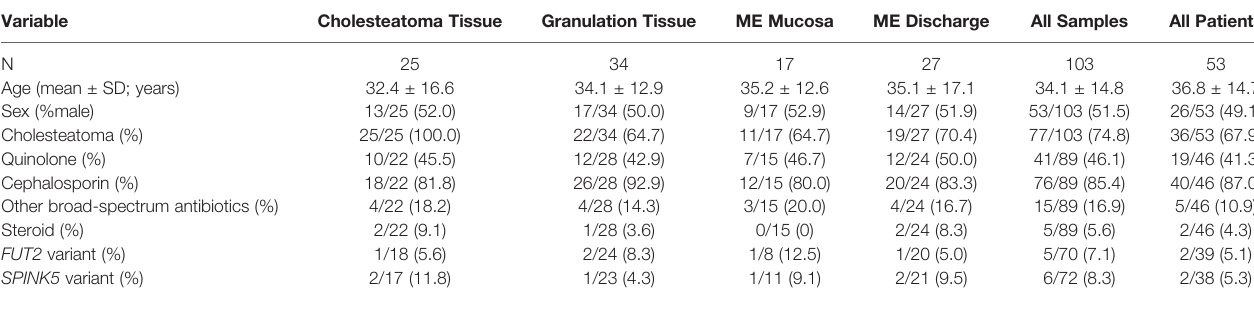
TABLE 1 | Clinical information and collected middle ear (ME) samples from 53 Filipino patients with chronic otitis media.